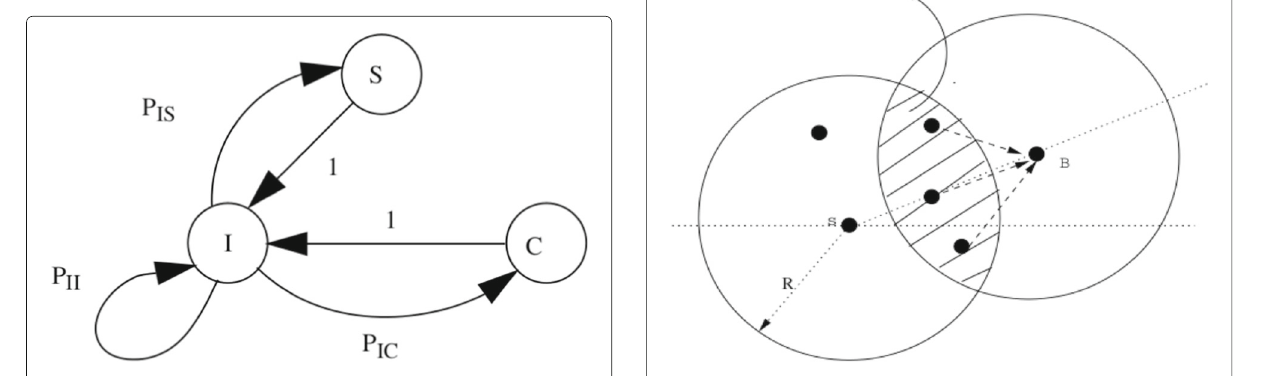
Fig. 1 Three-state Markov chain model of a node [3]